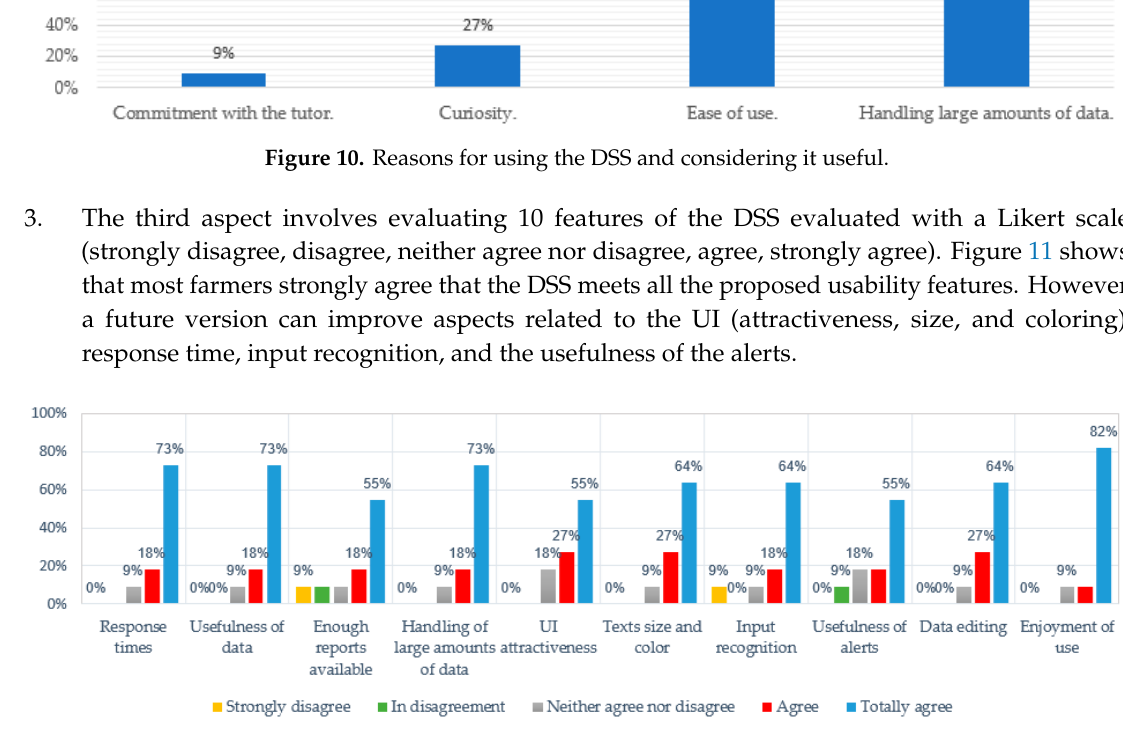
Figure 11. Results of the evaluation of the features.